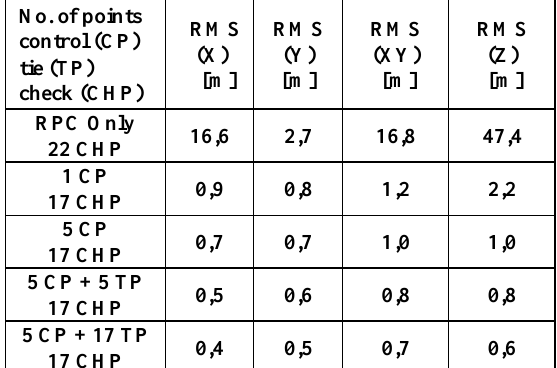
Fig.5 DAT/EM Capture Tools in ArcMap (Manual of SE).